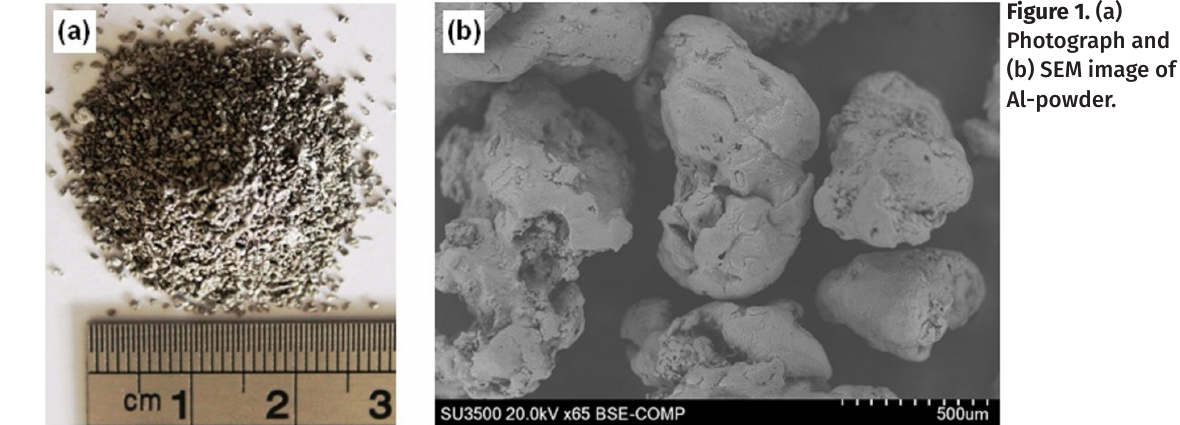
Figure 1. (a) Photograph and (b) SEM image of